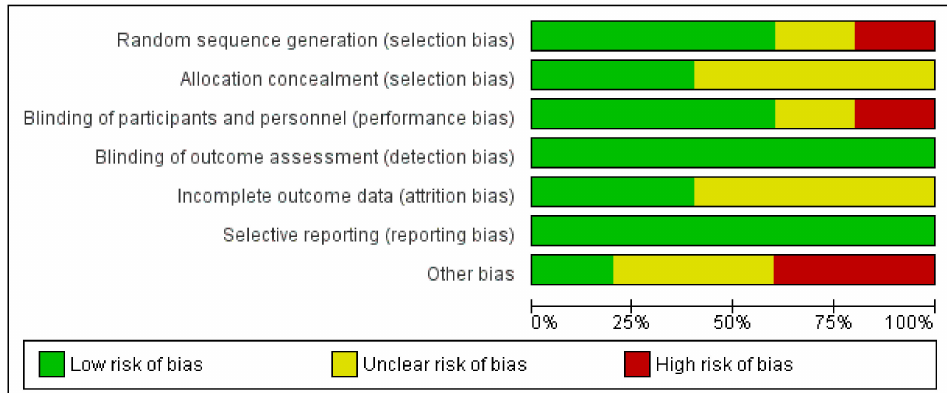
Figure 3. Risk of bias graph of clinical trial (CT): review authors’ judgments about each item as percentages across all included studies.